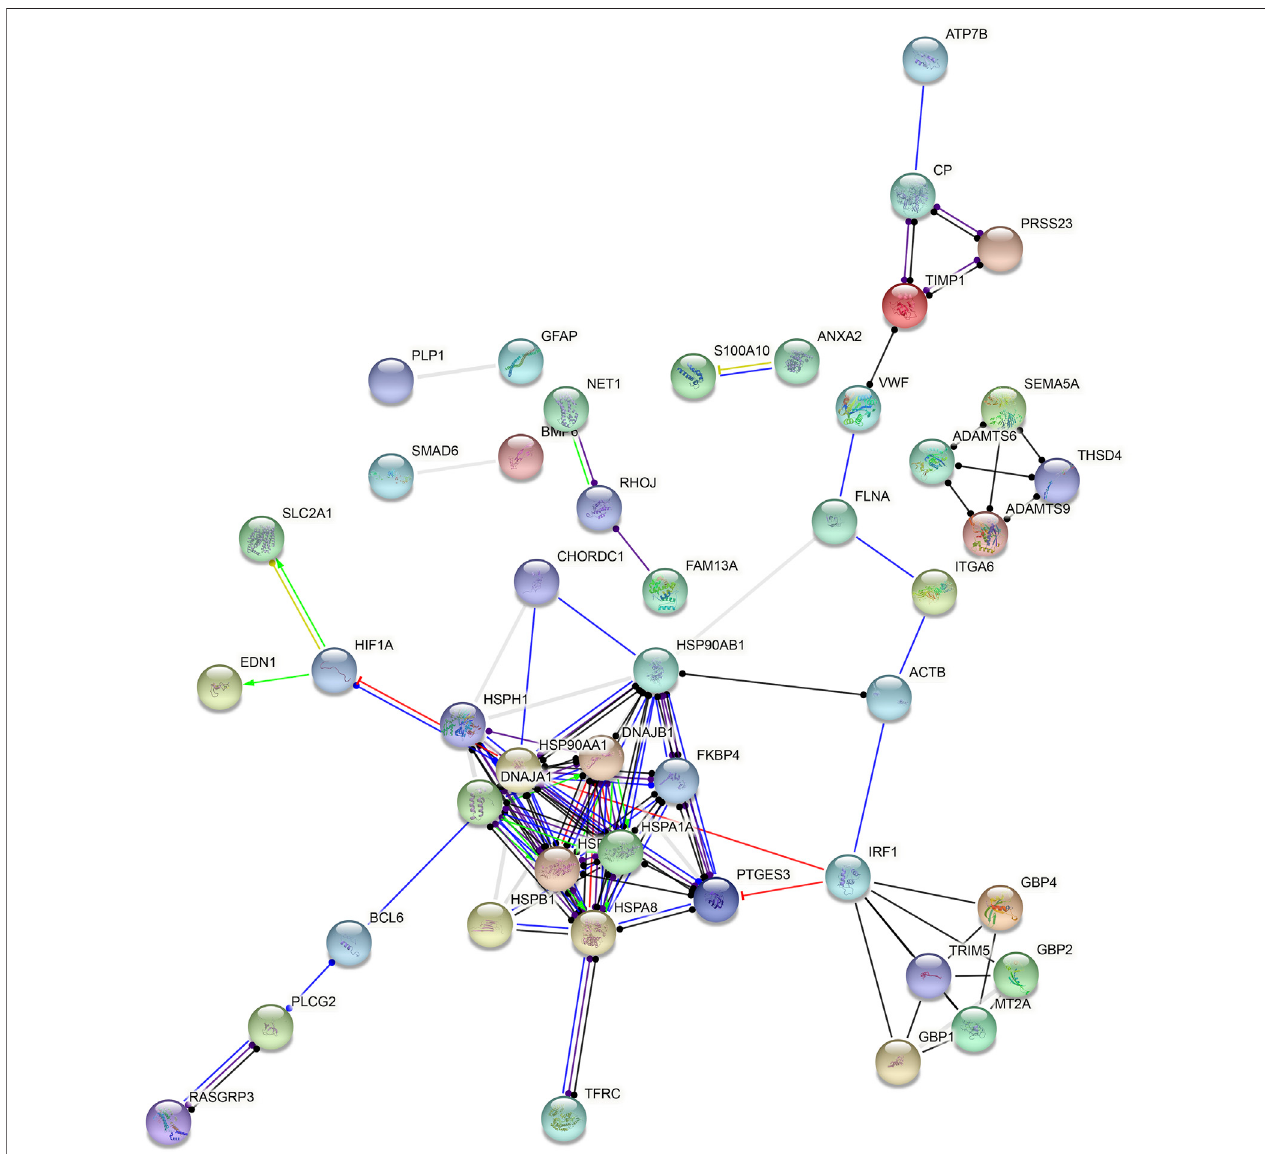
FIGURE 6 | Hub genes in endothelial cells. A PPI network was constructed based on all DEGs in endothelial cells.